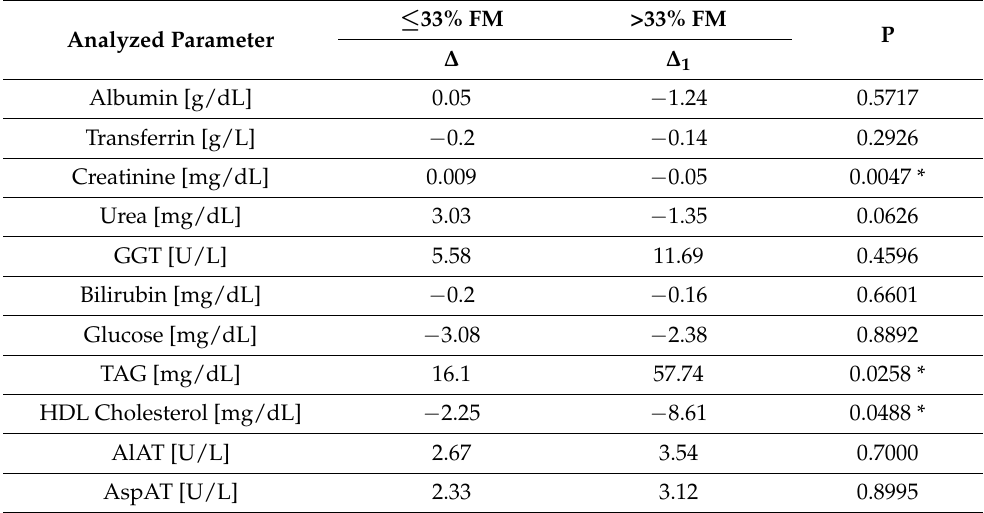
Table 6. Comparison of changes (before and after 6-week chemotherapy) for biochemical parameters depending on initial FM in the matched supplemented